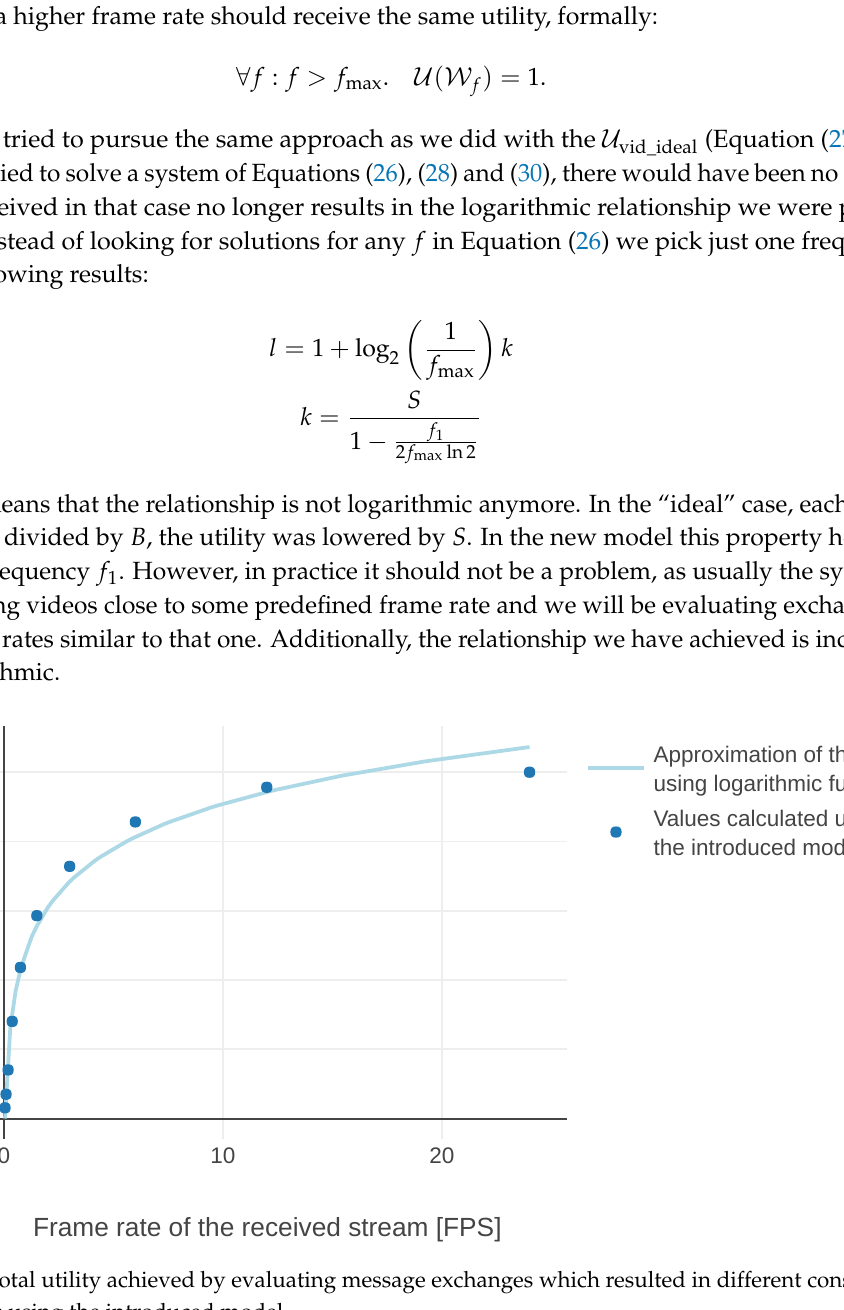
Figure 9. Total utility achieved by evaluating message exchanges which resulted in different constant frame rates using the introduced